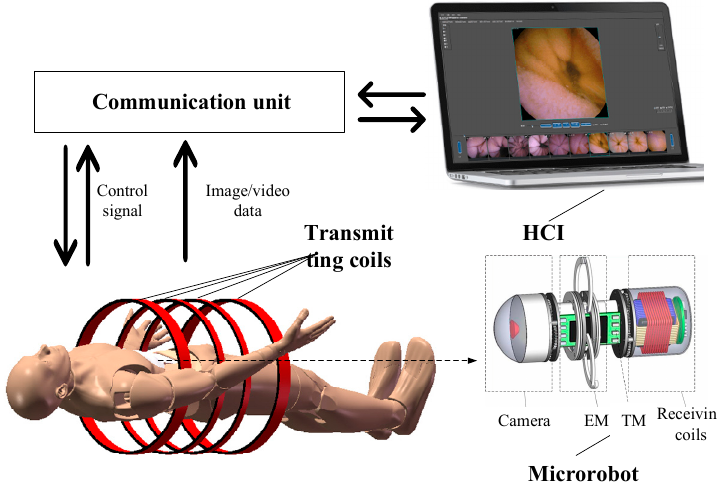
Figure 1. The non-invasive intestinal diseases detection system.